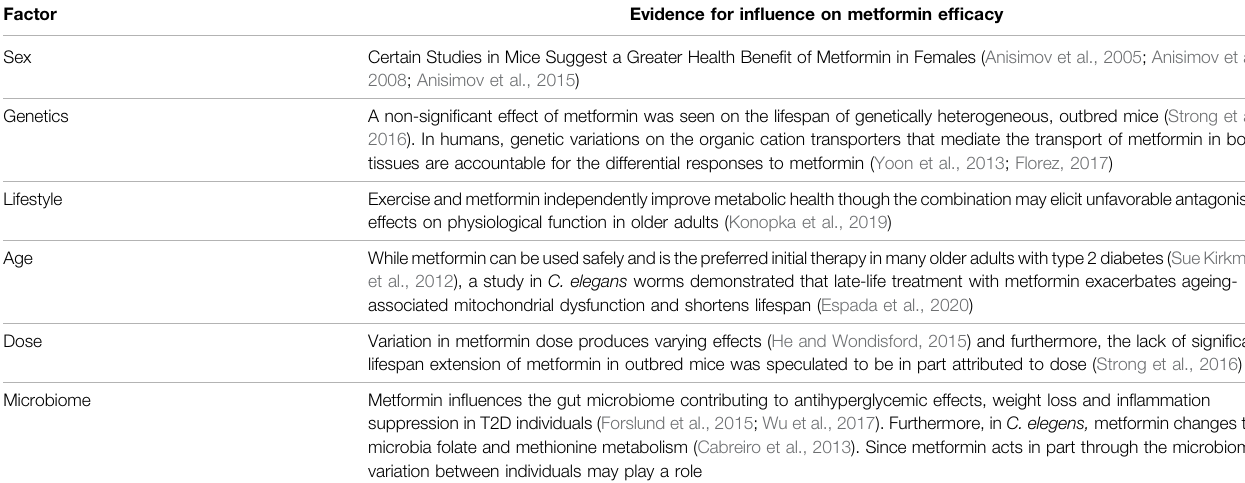
TABLE 1 | Overview of selected factors in fl uencing ef fi cacy of metformin. Factor Evidence for in fl uence on metformin ef fi cacy